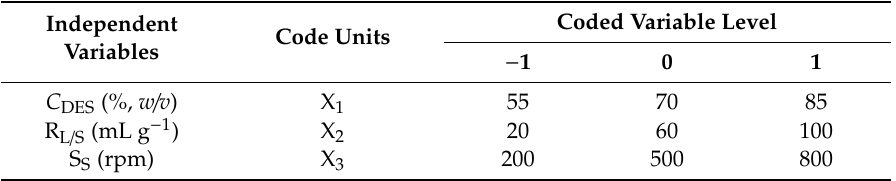
Table 1. Process (independent) variables used for the experimental design and their codified